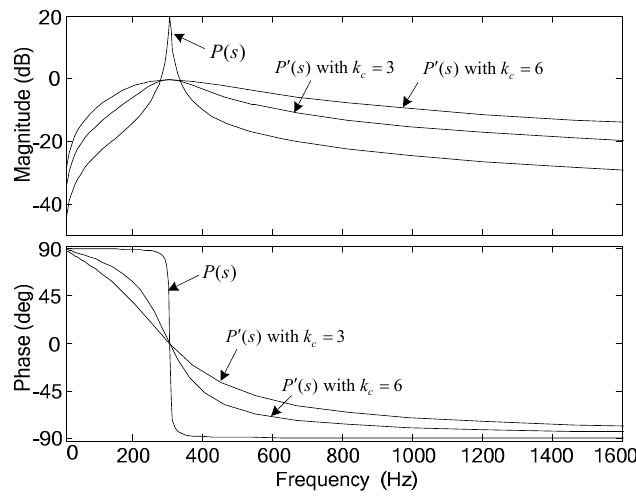
Figure 7. Bode plots of P(s) and P (cid:48) ( s )